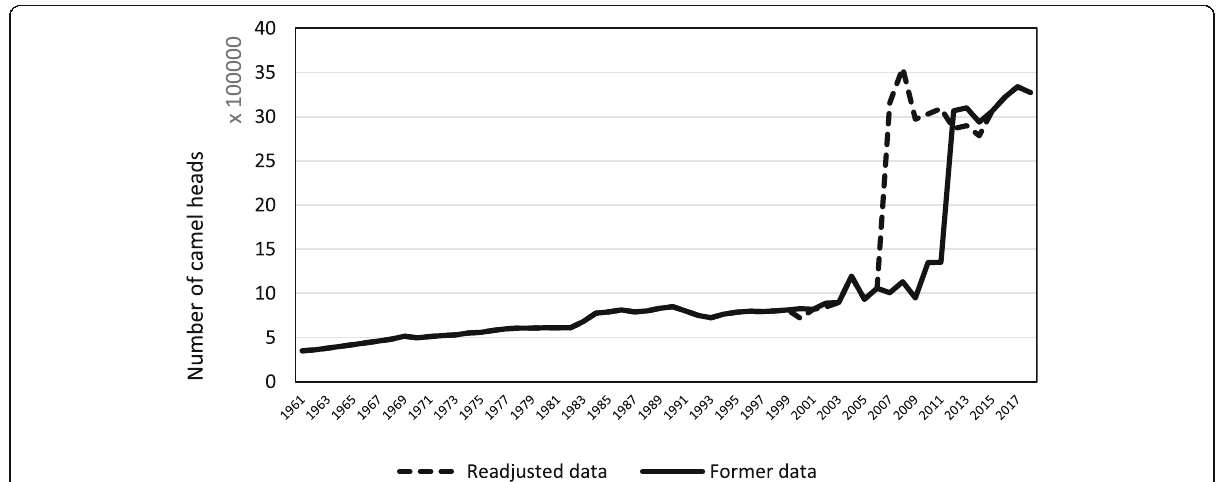
Fig. 10 Demographic changes of camel population in Kenya 1961 – 2018 before and after readjustment following the camel census